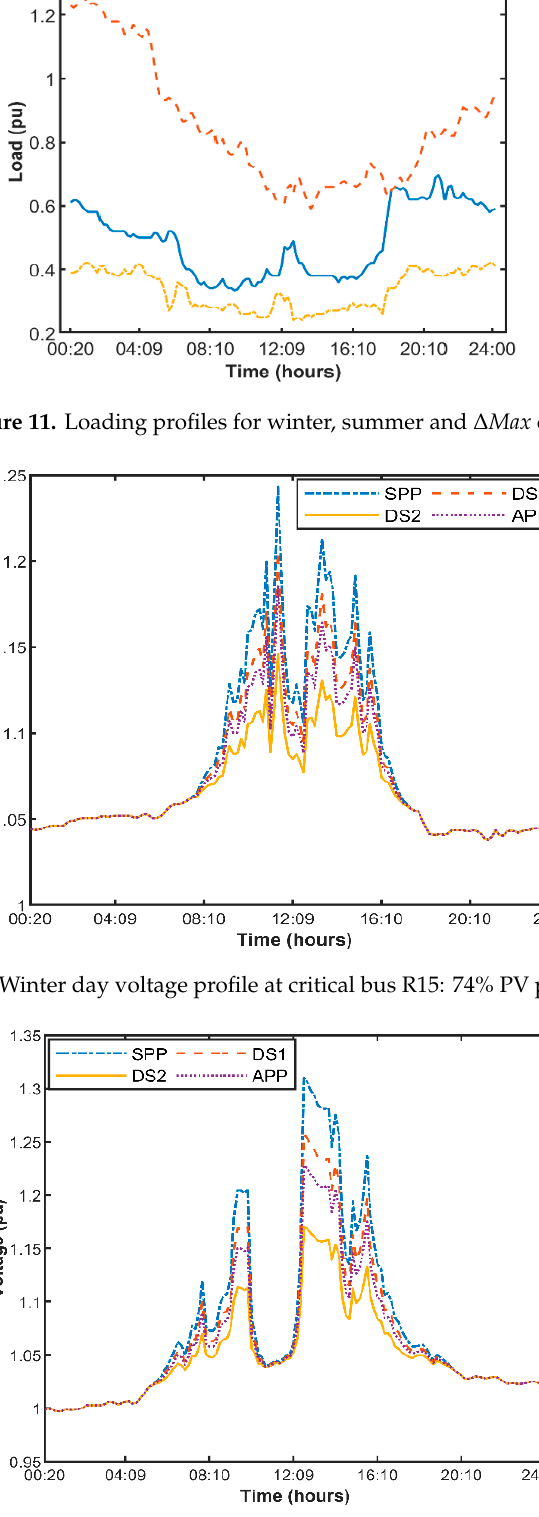
Figure 13. Summer day voltage profile at critical bus R15: 74% PV penetration.